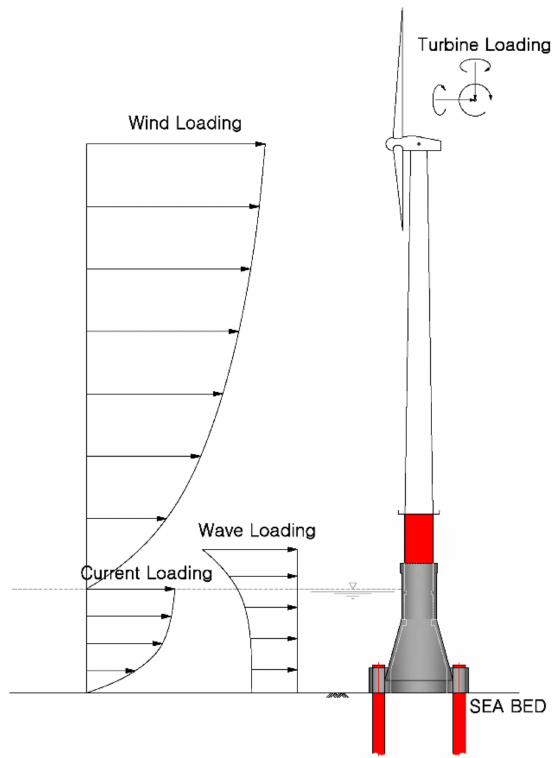
Figure 7. Load application to the support structure